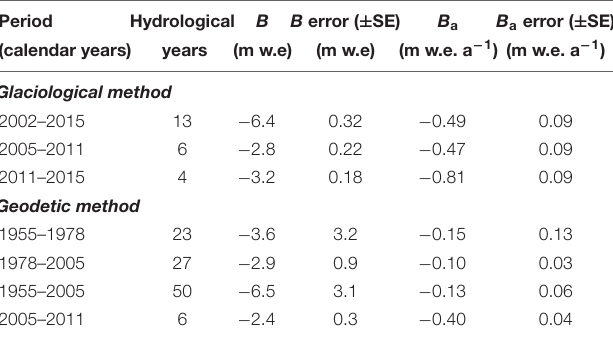
TABLE 2 | Comparison between glaciological and geodetic mass balance estimates of Guanaco Glacier.